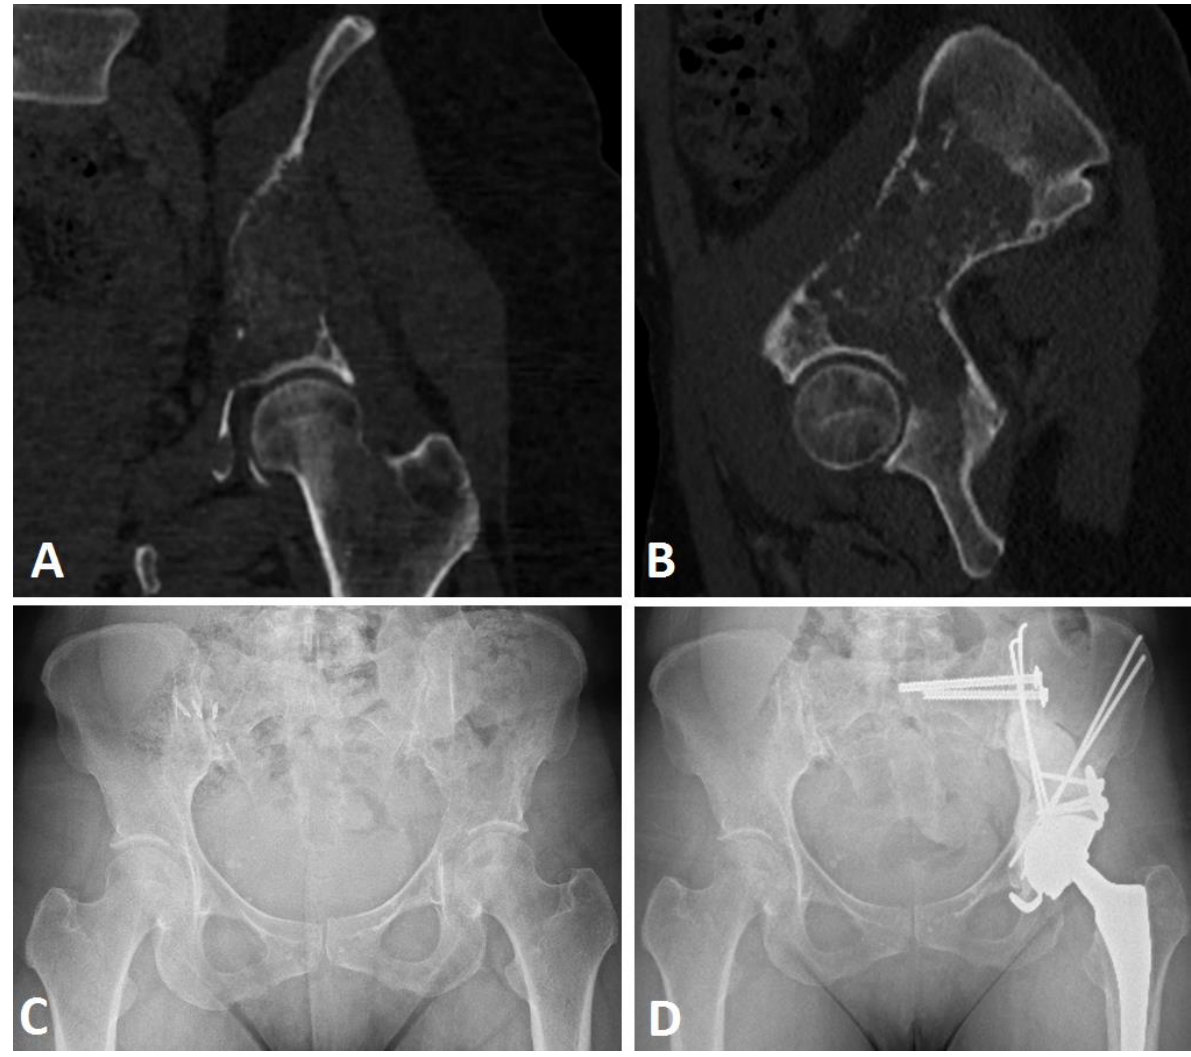
Figure 1. Harrington procedure (Steinman pins and cement) with THA with acetabular reinforce- ment using a Kerboul cross-plate and screws, and sacro-iliac joint screwing in a Harrington III lesion secondary to breast cancer. CT scan frontal ( A ) and sagittal ( B ), preoperative views, preoperative ( C ), and postoperative ( D ) AP X-ray views at 22 months of follow-up.